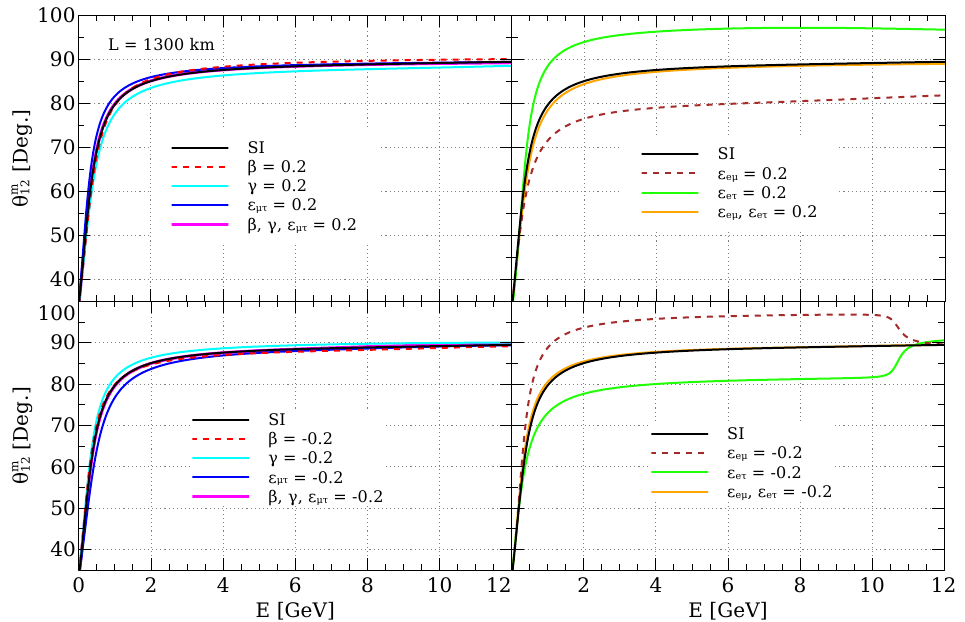
(given in eq. (4.4)) with energy in presence of SI and NSI in matter. The Figure 5 . Evolution of θ m 12 solid black curve in each panel shows the SI case while the other curves correspond to the variation in the presence of SI+NSI. In the top (bottom) row, the positive (negative) values of the NSI are considered with a benchmark value of 0.2 ( − 0 . 2 ). The left column depicts the presence of NSI parameters in (2,3) block while the right shows the effect of ε and ε . We consider L = 1300 km eµ eτ and assume NMO to prepare this plot. Values of oscillation parameters in vacuum used in this plot are taken from table 2 with θ = 45 ◦ 23